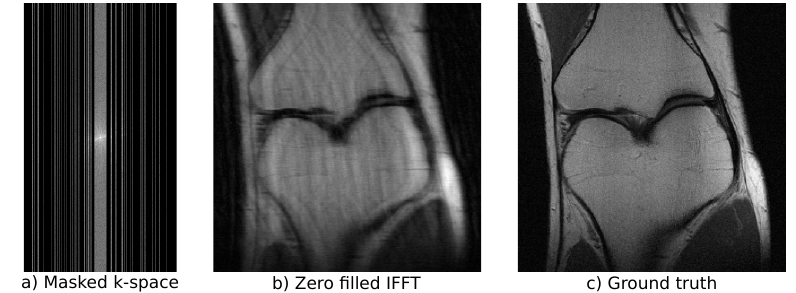
Figure 5. Measurements and reconstruction for the single-coil fastMRI data.